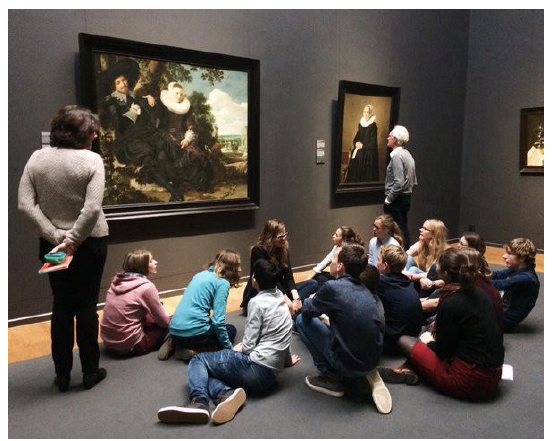
Figure 3: The Debriefing